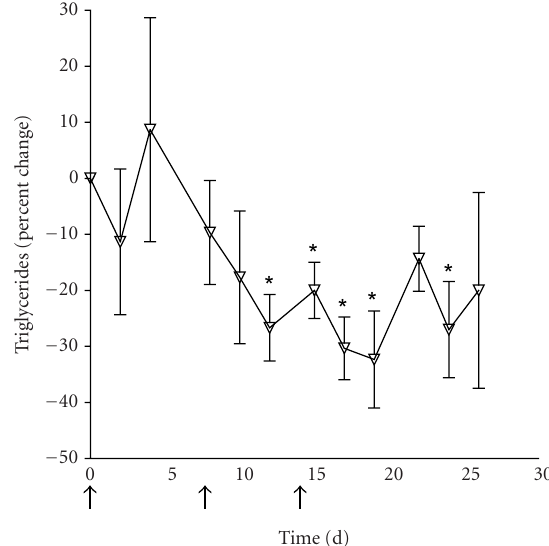
Figure 7. Average percent change in plasma triglyceride con- centrations in baboons after intravenous injections of the trun- cated apoC-I peptide at 10, 15, and 20 mg/kg at days 0, 7, and 14, respectively (arrows). The baboons were fed the HCHF diet. Values are expressed as mean ± SE, n = 3. Values significantly di ff erent from those at day 0 are marked by an asterisk ( P < .